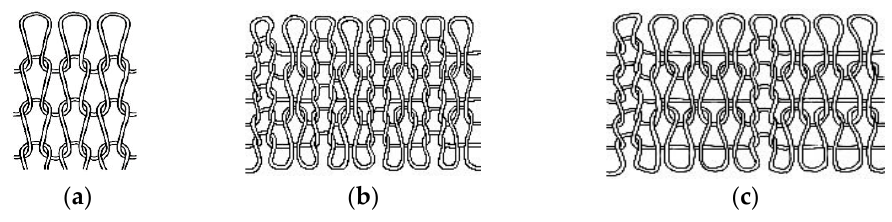
Figure 1. ( a ) The flat stitch; ( b ) the 1+1 simulated ribbed stitch; ( c ) the 1+3 simulated rib stitch.